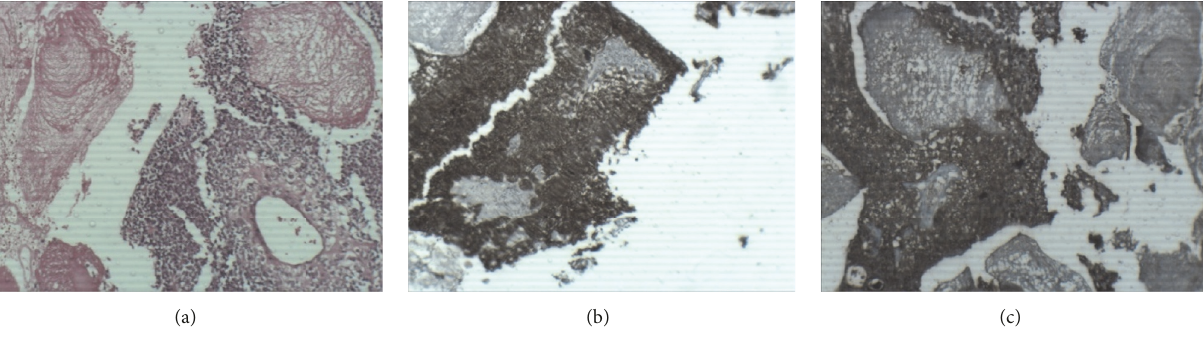
Figure 2: Photomicrograph (a) shows neoplastic tissue composed of solid, pseudopapillary structures lined by several layers of tumoral cells (original magnification, 100; hematoxylin-eosin staining). Photomicrograph (b, c) shows positive cytokeratin and EMA staining in tumoral cells, respectively (original magnification, 100; immunohistochemistry